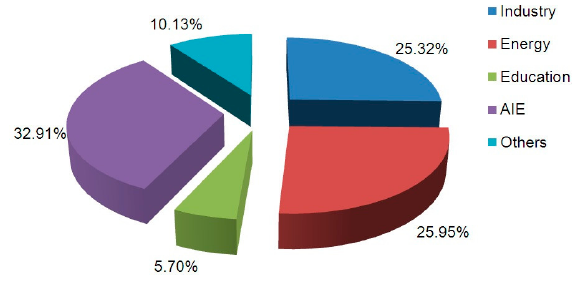
Figure 7. Distribution of reviewed papers per scope.